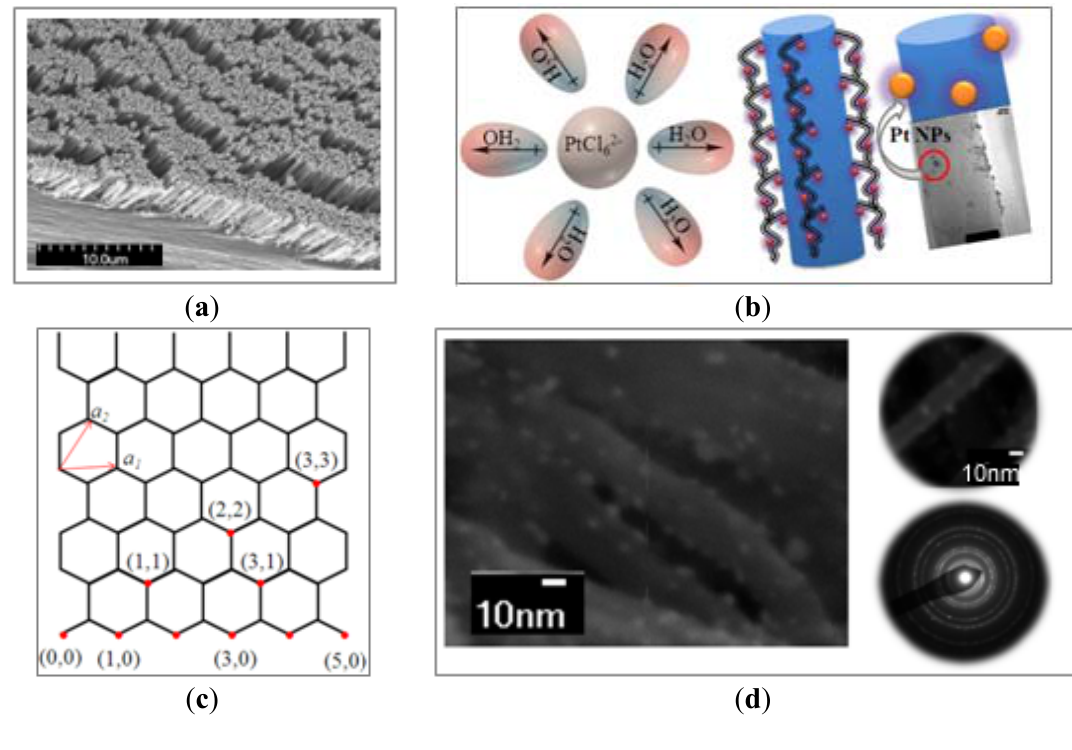
Figure 3. The microscopic characterization of functionalized CNTs: ( a ) the scanning electron microscopic (SEM) micrograph of aligned carbon nanotubes (ACNTs); ( b ) the van der Waal intermolecular forces is the major driving force for the CNT functionalization; ( c ) two lattice vectors of graphite to demonstrate the CNT circumference, which is equal to the length of the vector (n a + n a ), and the CNT chiral angle between vectors (n 1 1 2 2 a ) and a ; and ( d ) the transmission electron microscopic (TEM) micrograph to show the n 1 2 1 nanoscaled Pt, which was deposited on the surface of the nanotubes to increase the triple phase